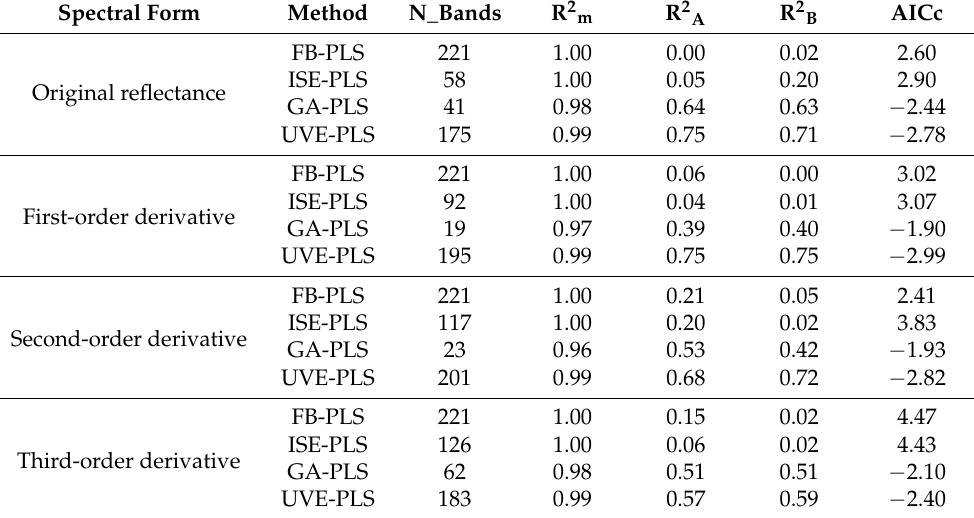
Table 1. PLSR model performance in estimating LNC from spectra within 1400–2500 nm with different band-selection methods. The number of bands (N_bands) used in each PLSR model and the coefficient of determination values for the simulation dataset (R 2 m ), dataset A (R 2 A ), and dataset B (R 2 B ) are shown in the